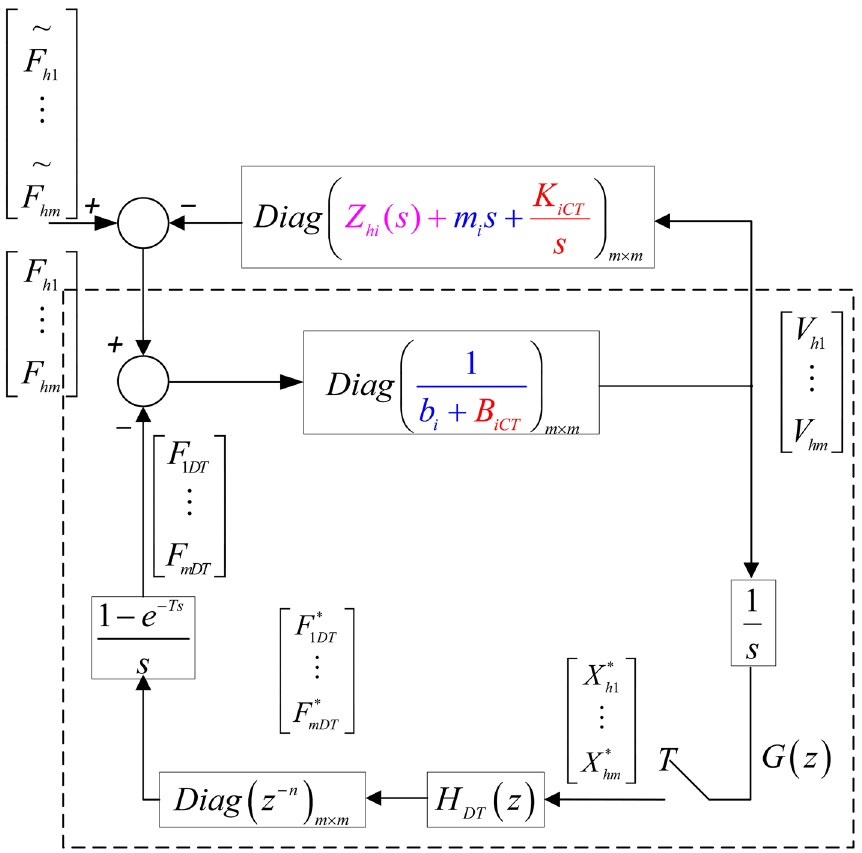
Figure 6. Simplified model of the one-dimensional multiple-user haptic virtual surgery simulation system with the analogue